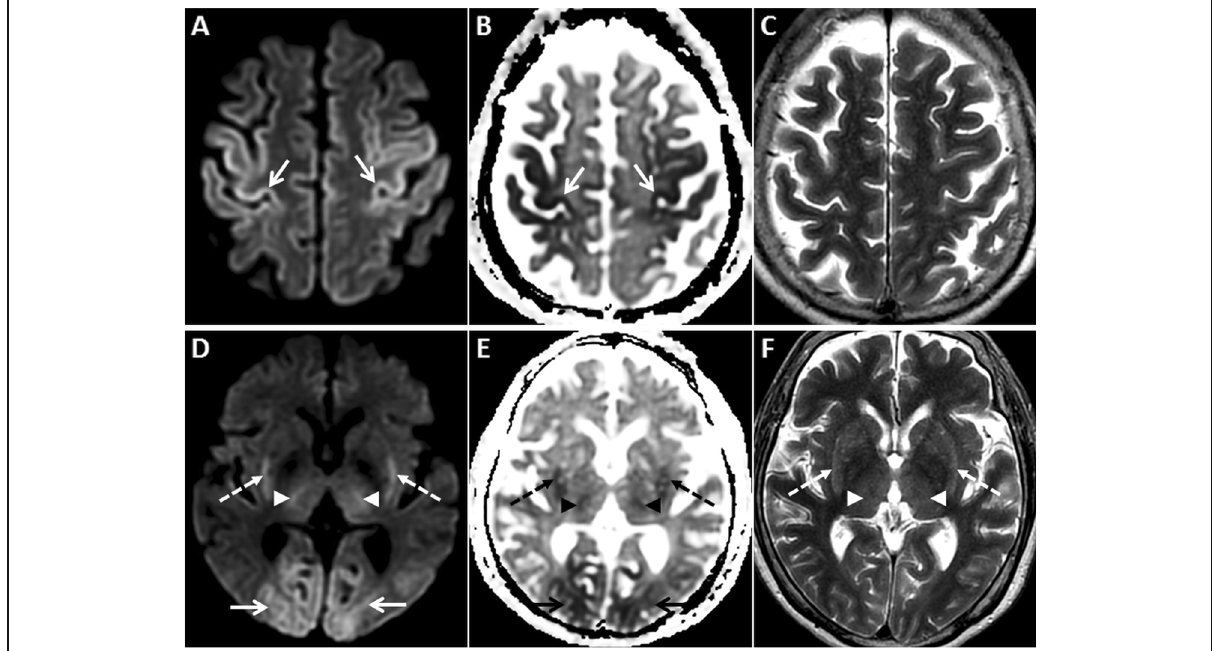
Fig. 1 MRI of the brain performed in the acute phase of HIE. On axial DWI ( a , d ) and axial ADC images ( b , e ), symmetric GRD is seen in the perirolandic cortices (arrows in a and b ) and in the visual cortices bilaterally (arrows in d and e ). Restricted diffusion is also observed in the putamina (dashed arrows in d and e ) and in the thalami (arrowheads in d and e ). Corresponding axial T2W images ( c , f ) demonstrate no obvious signal abnormality in the cortices. However, there is mild T2 hyperintensity in the putamina (dashed arrows) and in the thalami (arrowheads) ( f